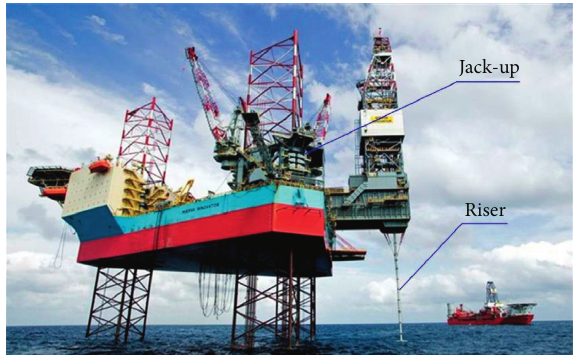
Figure 1: The working conditions of the jack-up platform with subsea